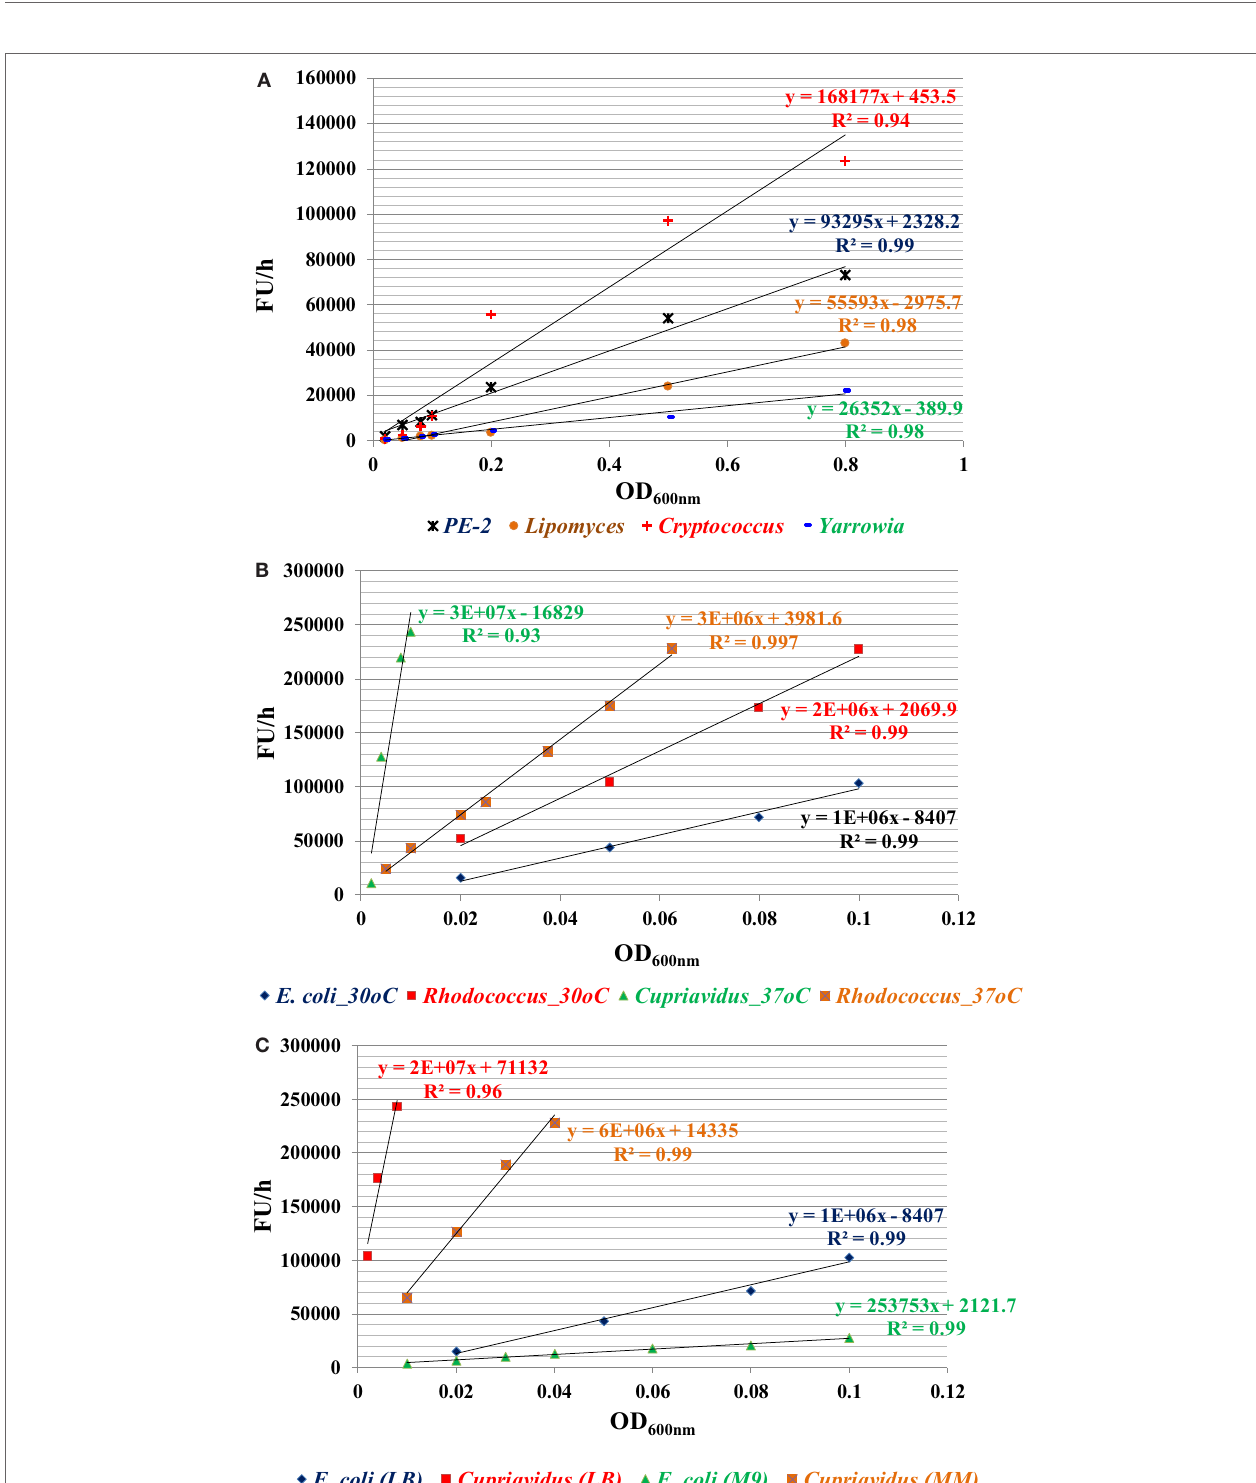
FigUre 1 | The metabolic capability indicator of fluorescence change rate ( Δ FU/h) for four yeast strains in YPD medium (a) , three bacterial strains in lysogeny broth (LB) (B) , and two bacterial strains of E. coli and C. necator in LB or MM (c) . The specific metabolic activity ( Δ FU/h/OD 600nm ) can be calculated by the slope of these curves. Three replicates for each condition in one plate and three plates were used for each data point by taking readings every 30 min or 1 h depending on the metabolic activity of the microorganisms until the fluorescent signal was saturated. The experiment was repeated at least two times with similar